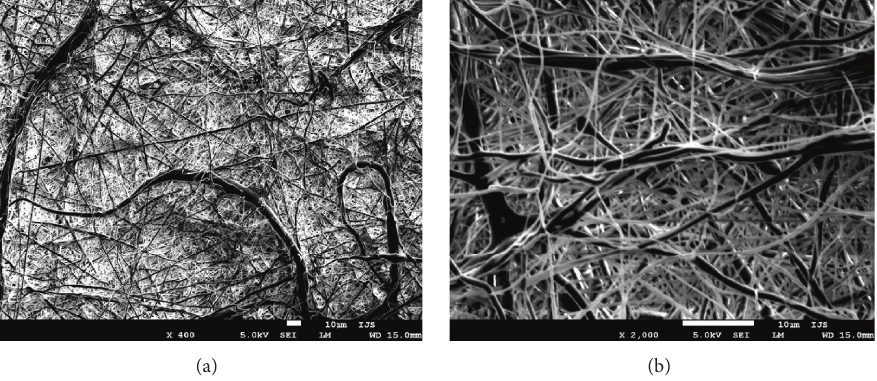
Figure 1: SEM image of electrospun PCL membranes at two different magnifications: (a) 400x magnification and (b) 2,000x magnification.